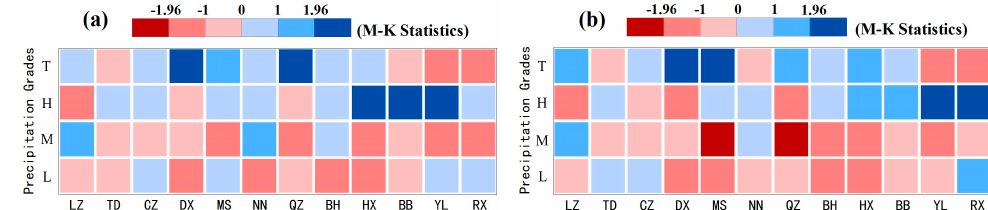
Figure 9. Variation tendency of incidence rate ( a ) and contribution rate of different grades ( b ) in rainy season at 12 stations in the Beibu Gulf. The letters along the y-axis denoted precipitation grades. L is Light rain, M is Moderate rain, H is Heavy rain and T is Torrential rain. The letters along the x-axis denoted names of the precipitation stations: Longzhou (LZ), Tiandeng (TD), Chongzuo (CZ), Dongxing (DX), Mashan (MS), Nanning (NN), Qinzhou (QZ), Beihai (BH), Hengxian (HX), Bobai (BB), Yulin (YL), and Rongxian (RX).